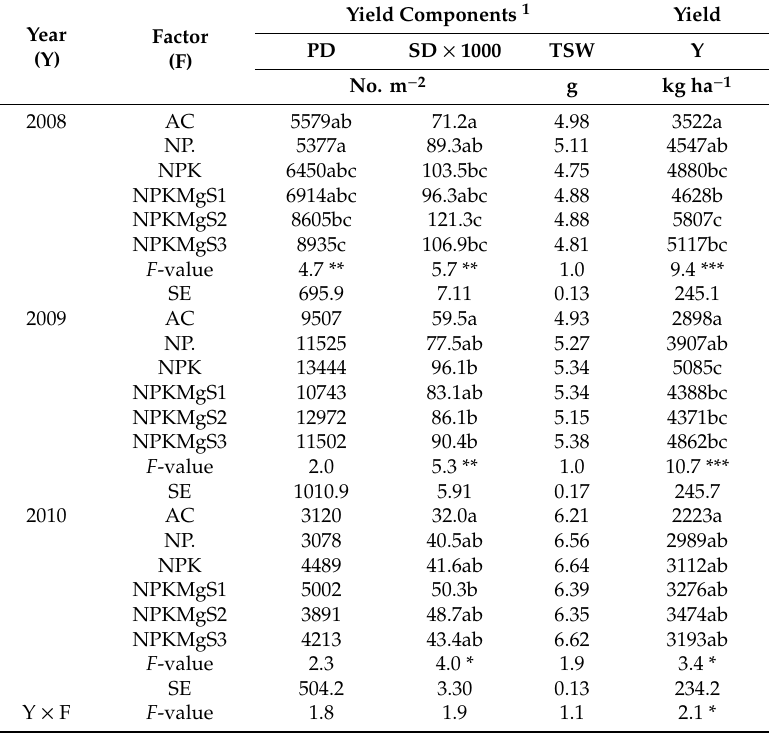
Table A1. Yield components and seed yield of winter oilseed rape response to fertilization